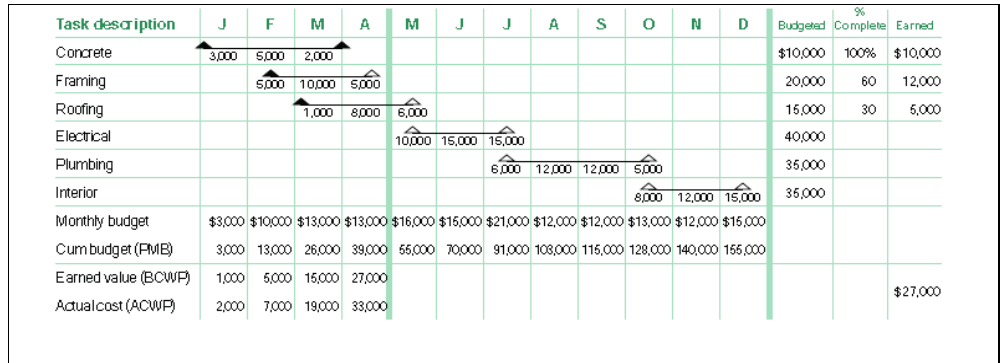
Fig. 2a. Monthly program assessment using Earned Value (GAO 09-3SP, 2009: p. 250).